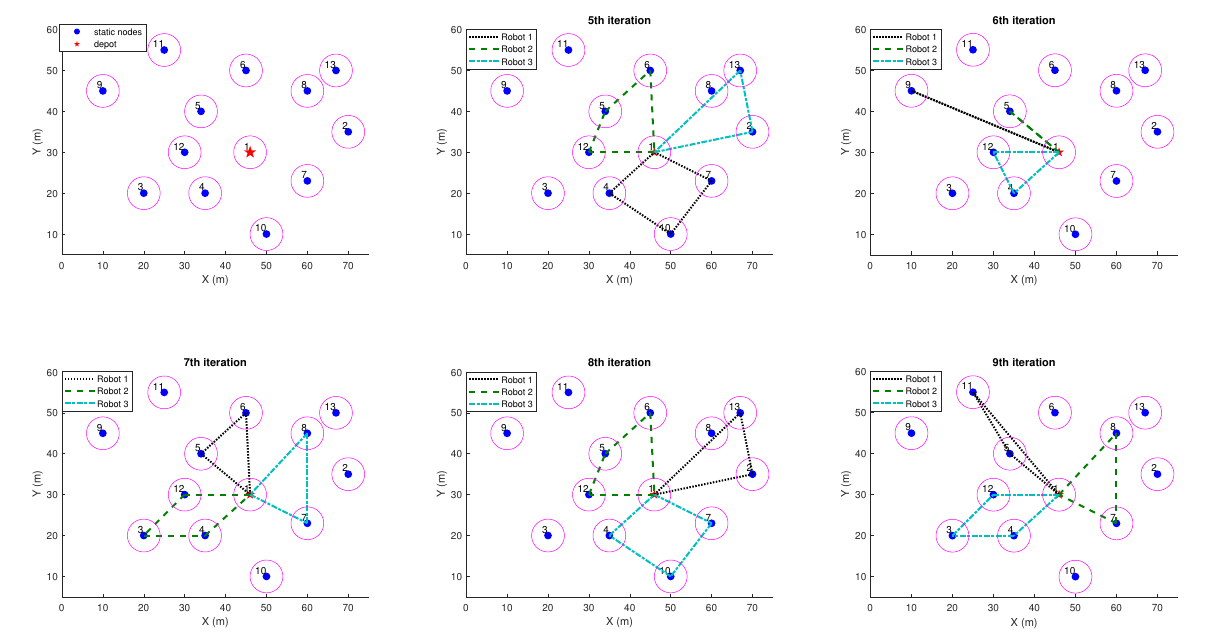
Figure 4. Mobile Element Scheduling Routes with 3 MoEls and 13